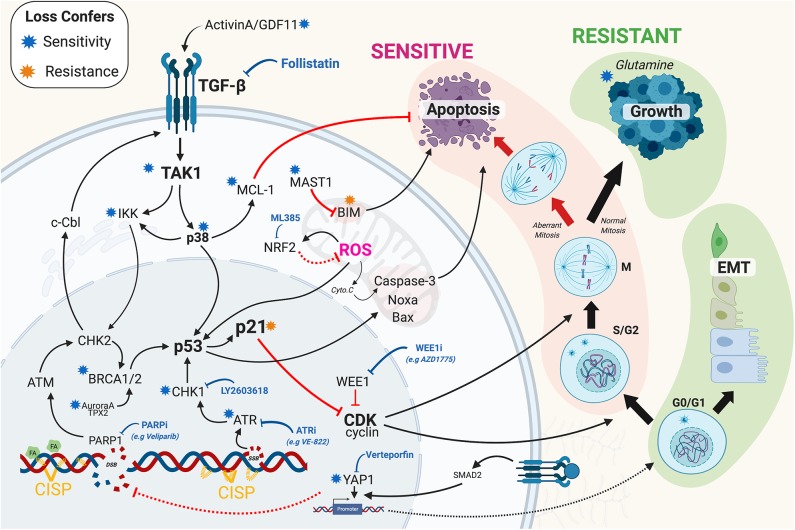
Overview of the recent mechanisms of resistance identified in lung adenocarcinoma. Briefly, mechanism of resistance work to increase repair of DNA damage and or prevent the triggering of cell death through inhibition of apoptotic signaling. Black solid arrows indicated activation. Red arrows indicate inhibition. Solid and dashed lines indicate direct and indirect mechanisms. Blue and orange stars indicate that loss (e.g., by RNAi, CRISPR, or chemical inhibition) confers sensitivity and resistance to cisplatin, respectively. Blue block arrow indicates potential therapeutic cisplatin synergistic treatment options. CISP, cisplatin; EMT, epithelial-mesenchymal transition; SSB/DSB, single/double strand breaks; FA, Fanconi Anemia pathway; ROS, reactive oxygen species; Cyto.C, Cytochrome C. The Figure created with BioRender.com.